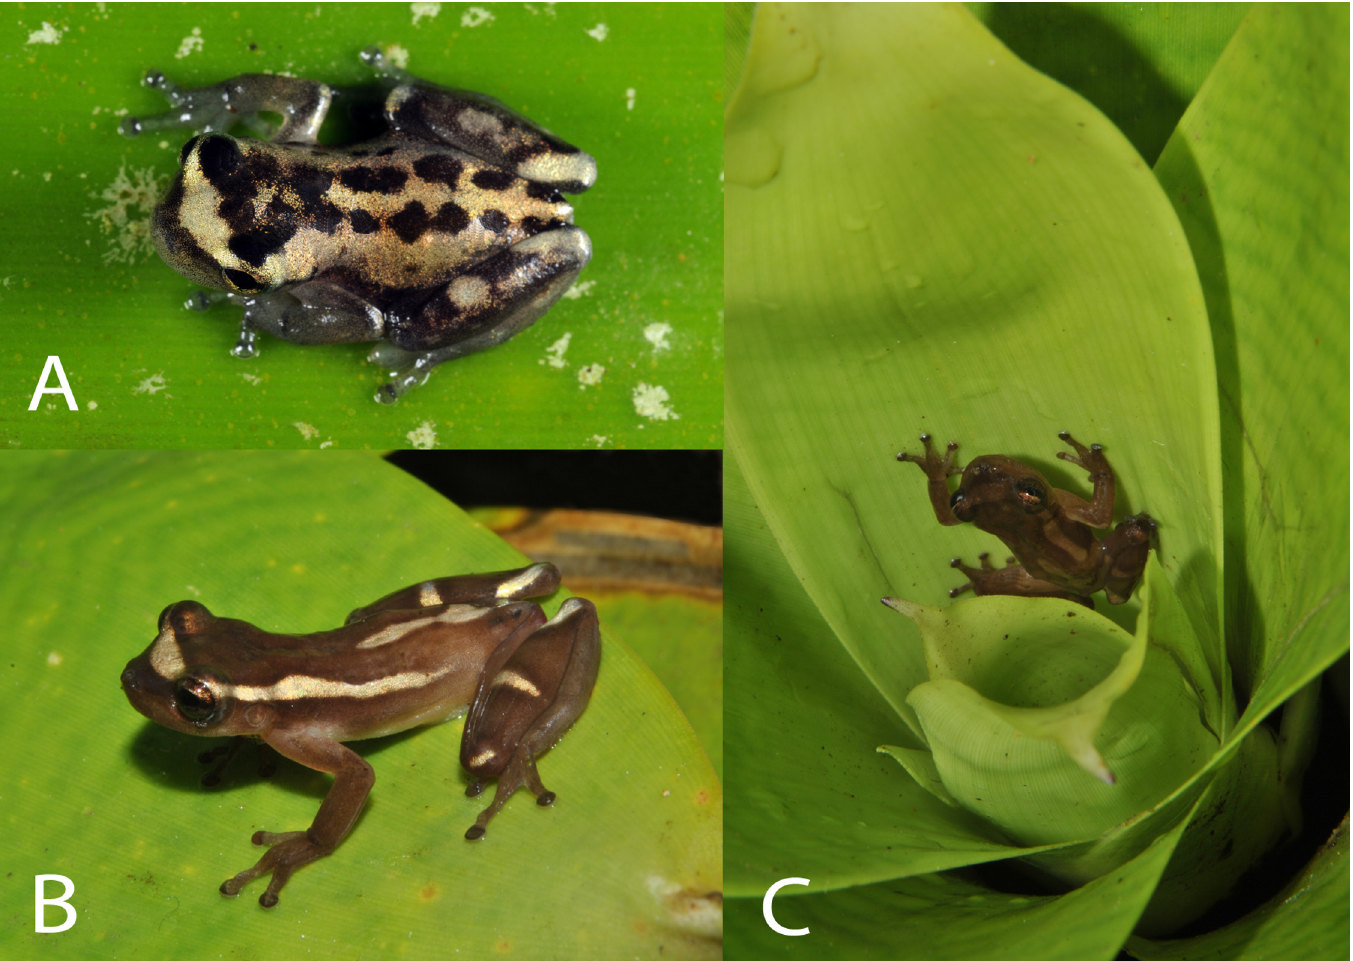
Fig 3. Dendropsophus bromeliaceus sp. nov. in life. (A) froglet (MNRJ 85855), and (B and C) male paratopotype (MBML 7712).